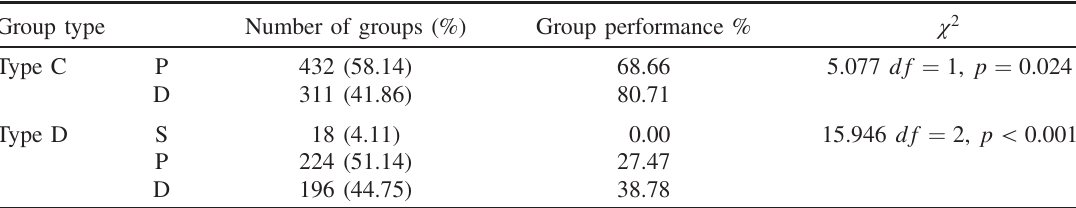
TABLE V. Group performance according to the variety of individual-round answers in the group. Type C-D is the same as type C-N, also, type D-D is the same as type D-N. α is